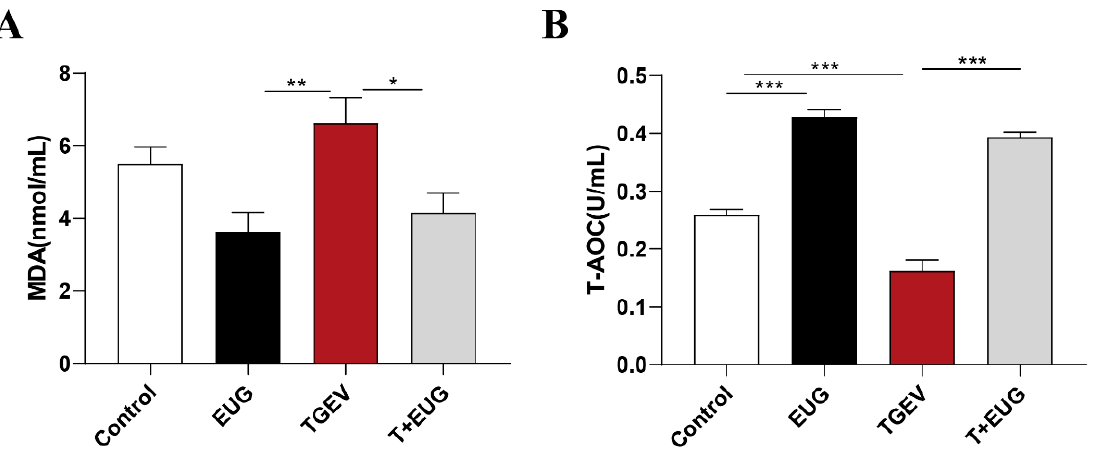
Figure 1. Effects of eugenol on serum antioxidant indicators in TGEV-infected weaned piglets. ( A , B ) The levels of MDA and T-AOC in serum ( n = 8). Data are expressed as the mean ± SEM. * p < 0.05, ** p < 0.01, *** p < 0.001.